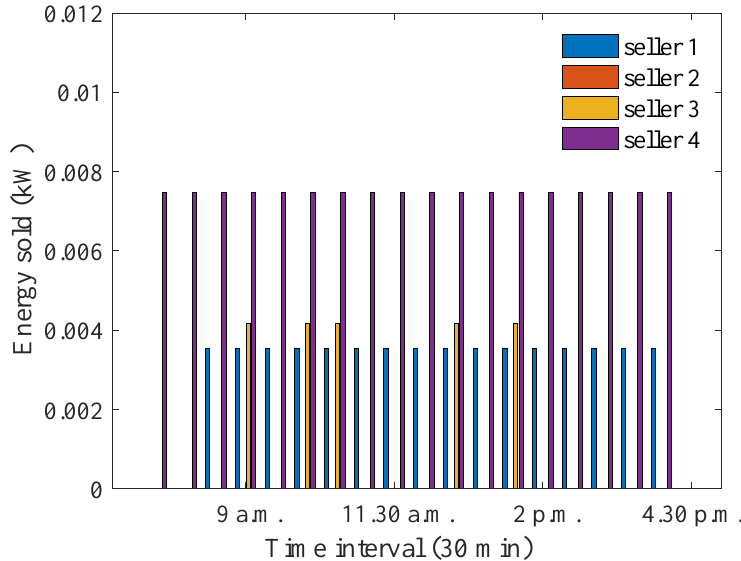
Figure 23. Optimum energy sold for equally preferred sellers and buyers when distance between house 1 and the aggregator is increased.